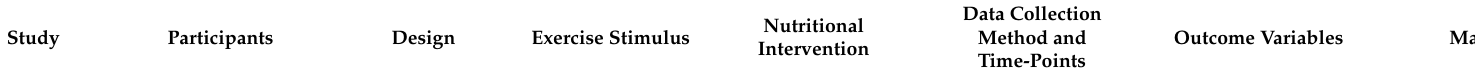
Table 2. Studies examining the e ff ect of honey supplementation over the course of multiple weeks on biochemical responses to